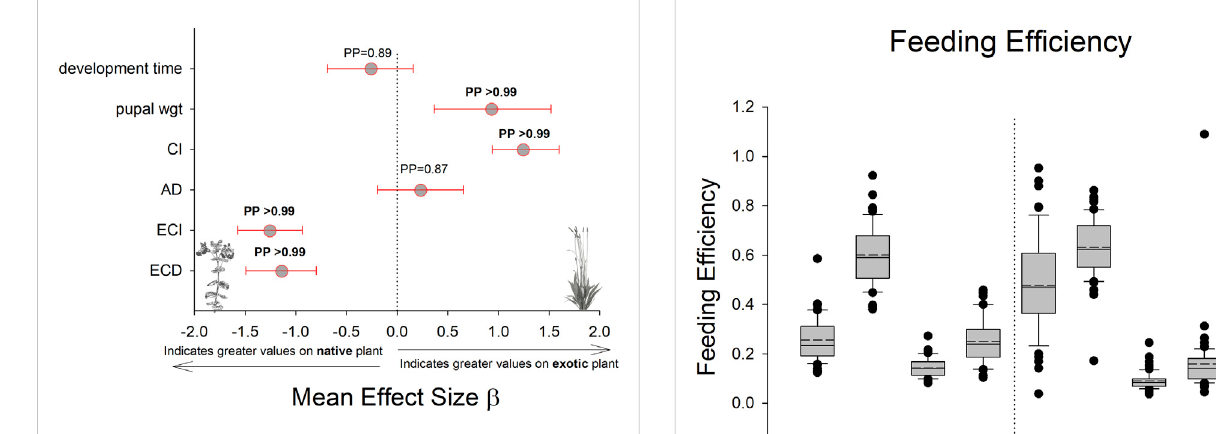
PP = 0.99, Figure 2; Figure 4) compared to individuals reared on M.